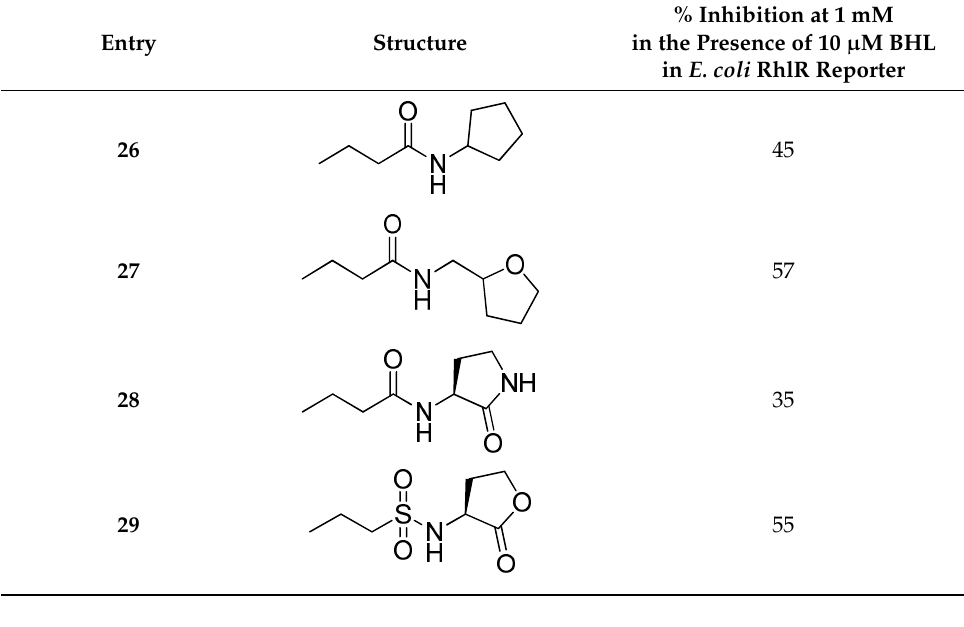
Table 4. Phenylacetyl or phenoxyacetyl analogs as RhlR antagonists.